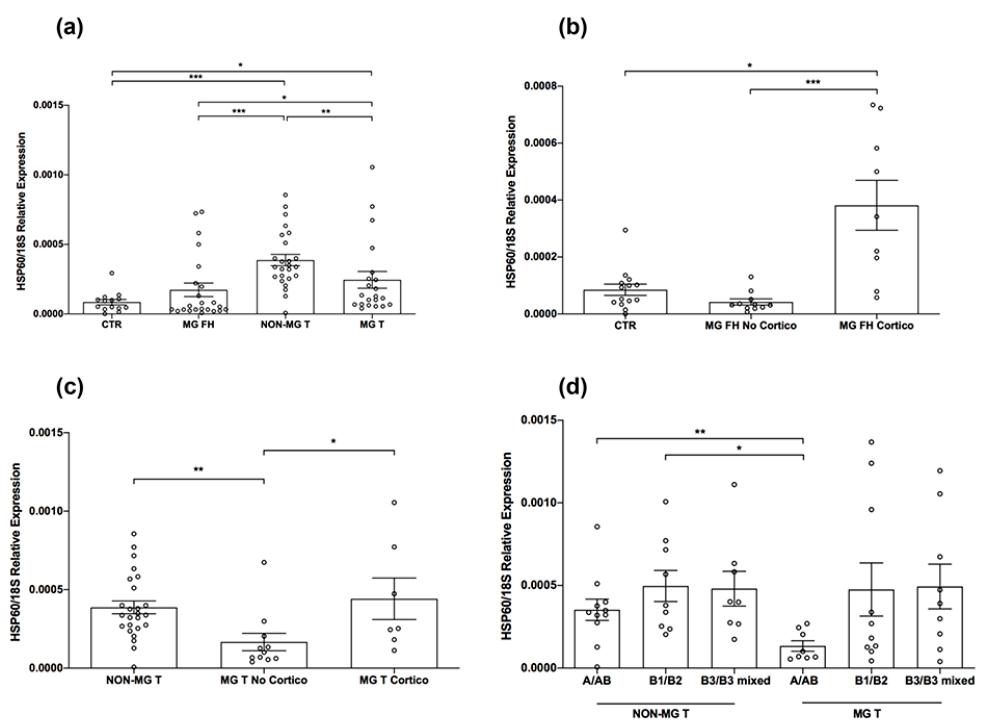
Figure 5. HSP60 expression in MG and control thymuses. ( a – d ) HSP60 mRNA levels in normal thymuses (CTR), follicular hyperplastic (MG FH) thymuses from MG patients stratified in corticosteroid-naïve (MG FH No Cortico) and -treated (MG FH Cortico), thymomas from non-MG patients (NON-MG T), thymomas (MG T) from MG patients stratified in corticosteroid-naïve (MG T No Cortico) and -treated (MG T Cortico), and NON-MG T and MG T stratified according with WHO thymoma type. In the graphs, gene expression levels were expressed as relative values (2 − ∆ Ct × 100) normalized toward the endogenous 18S. Mann–Whitney test, * p < 0.05; ** p < 0.01; and *** p < 0.001.